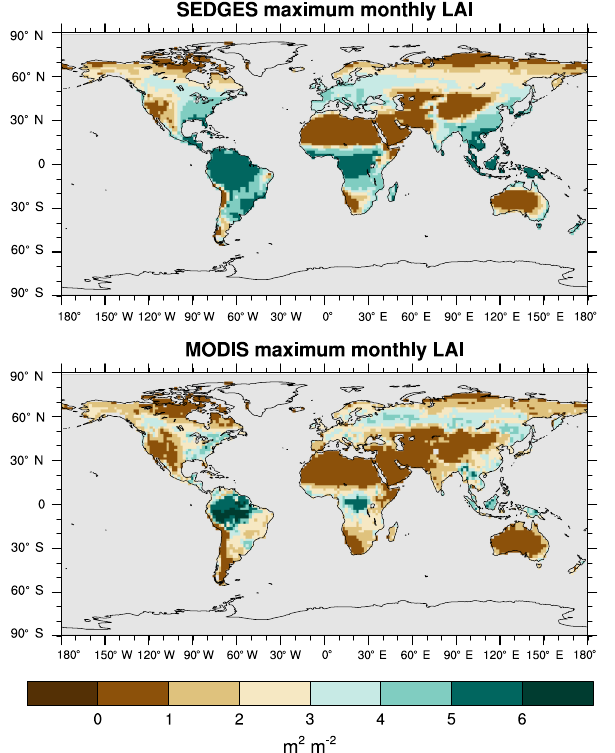
Figure 13. Maximum LAI of the multiyear monthly means for SEDGES and for the BNU MODIS-based reference dataset for the 2001–2010 period.